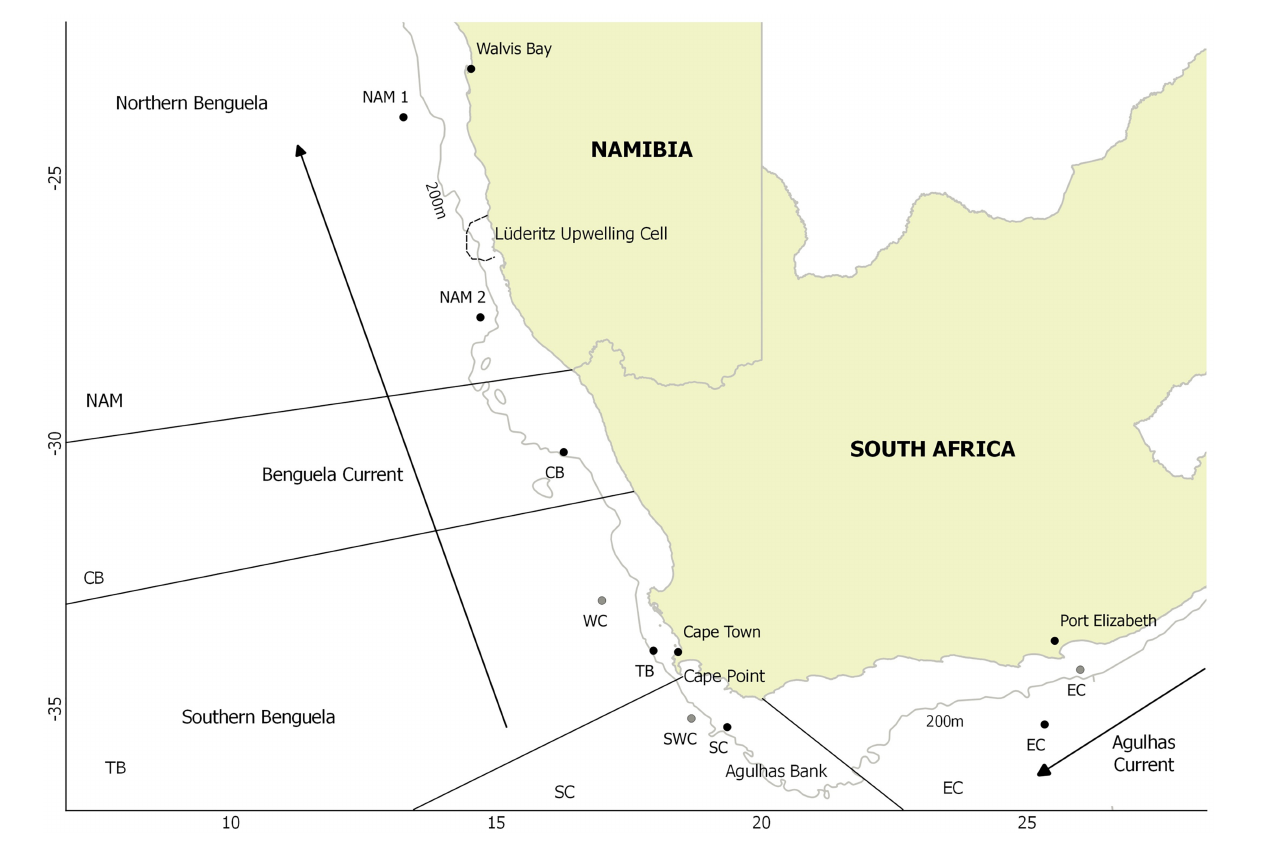
FIGURE 1 | Sampling locations for kingklip: black 2017, gray 2012, 2014, and 2015. CB – Child’s Bank, WC – West Coast, TB – Table Bay, SWC – South West Coast, SC – South Coast, EC – Eastern Cape and NAM – Namibia. Depth contour (200 m) as well as oceanographic features indicated (including the Agulhas Current, Benguela Current and approximate location of the Lüderitz upwelling cell and the Agulhas Bank).